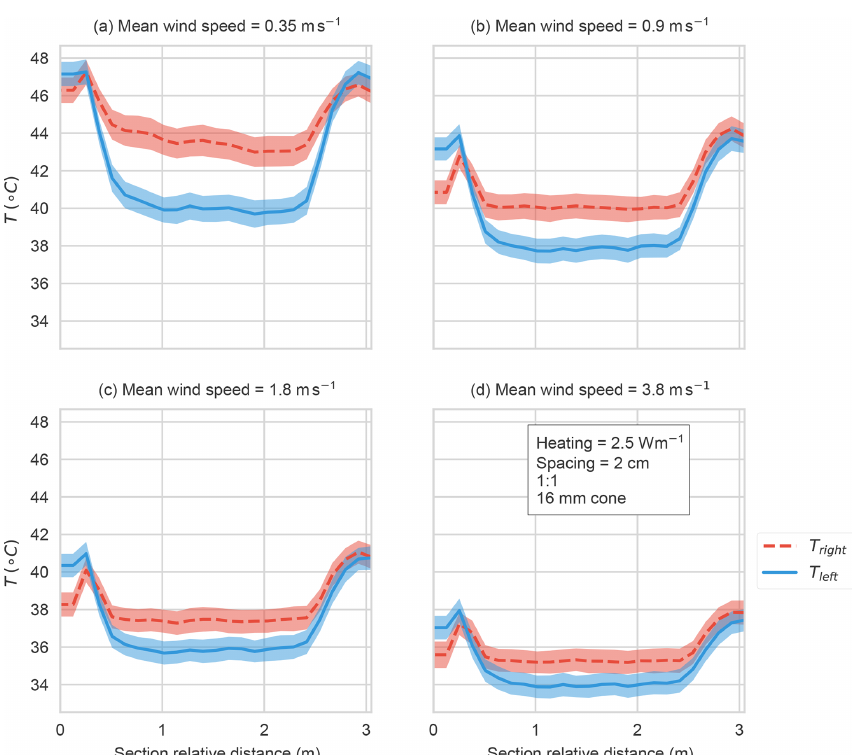
Figure 2. Time-averaged temperature (10min) along the test section in the wind tunnel for a horizontal wind speed of (a) 0.35, (b) 0.9, (c) 1.8, and (d) 3.8ms − 1 for the parameters listed. The standard deviation of temperature in time for each point along the FOC is shown in the filled colors. The cones are only present between 0.75m and 2.25 of the tunnel section. The mean wind direction is in the positive x